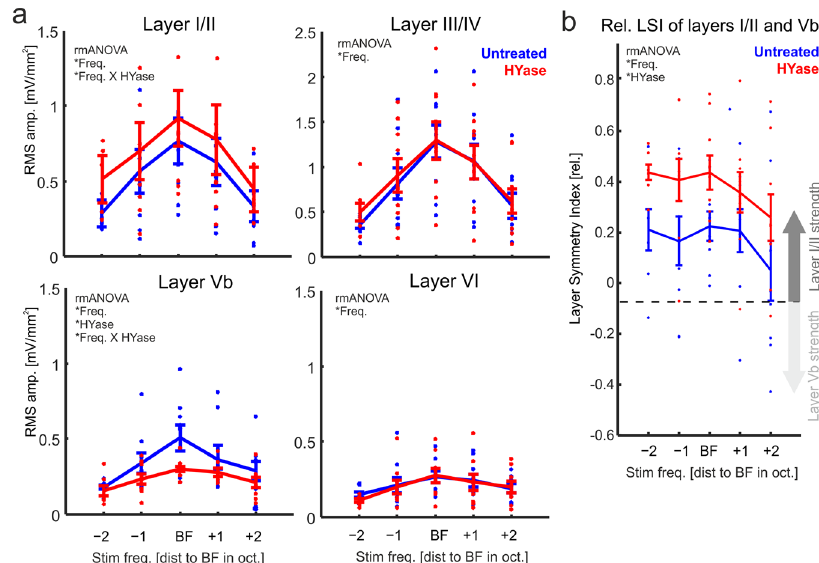
Fig. 2 Removal of the ECM affects layer-speci fi c processing in the auditory cortex. a Frequency-response tuning curves for the RMS amplitude (±SEM) of CSD traces from individual cortical layers showed increased activity within supragranular layers I/II and decreased activity in cortical layer Vb ( n = 9; represent by individual data points for each animal). Activity in layers III/IV and VI did not change. b Correspondingly, the Layer- Symmetry-Index LSI = (I/II – Vb)/(I/II + Vb) showed that after HYase treatment evoked synaptic activity shifted towards supragranular layers independent of the stimulation frequency. Signi fi cant main effects and interactions of a 2-way-rmANOVA are indicated in each subpanel (for results see Table